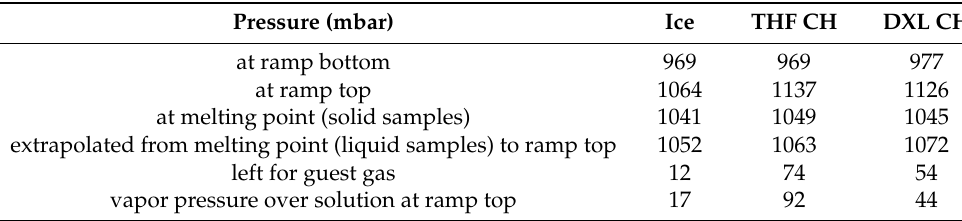
Table 1. Pressure values as extracted from Figure